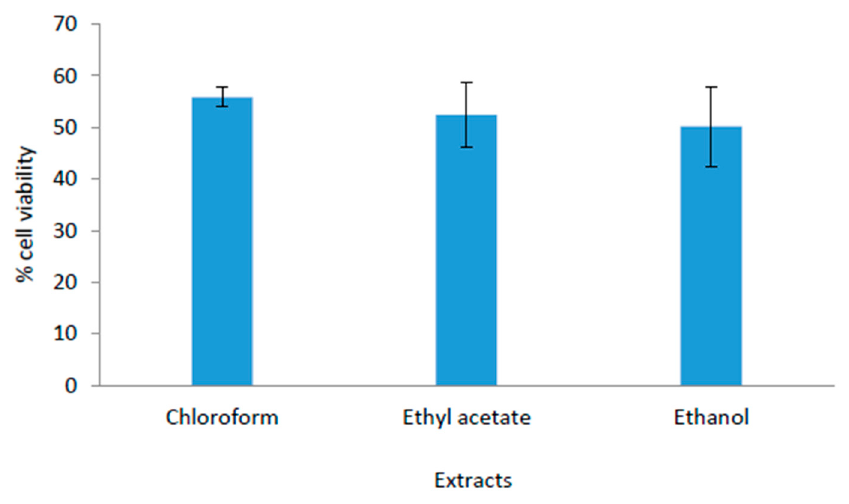
Figure 1. Cytotoxic effect of chloroform, ethyl acetate and ethanol extracts of O. genistifolia .